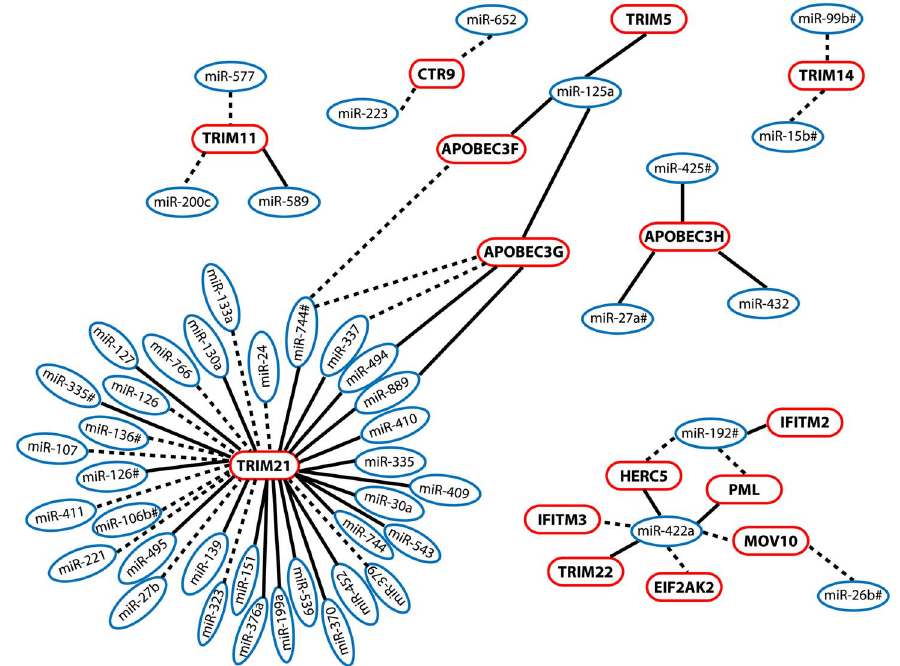
Figure 4. Global network of putative regulatory interactions between miRNAs and anti-HIV-1 restriction factor mRNAs. miRNA and mRNA expression data were measured in longitudinal PBMC samples from IFN- a /RBV-treated patients enrolled in the SHCS. Two variables were used to generate the network: 1) inverse expression relationships between a given miRNA-mRNA pair (represented as a dashed line drawn between a miRNA – mRNA pair), and 2) Significant sequence homology between a given miRNA seed region and a restriction factor 3 9 UTR (word size 4, alignment length . =5, e-value , 1.0). Significant sequence homology is represented by a solid line. miRNAs are listed in blue; restriction factors are listed in pink.